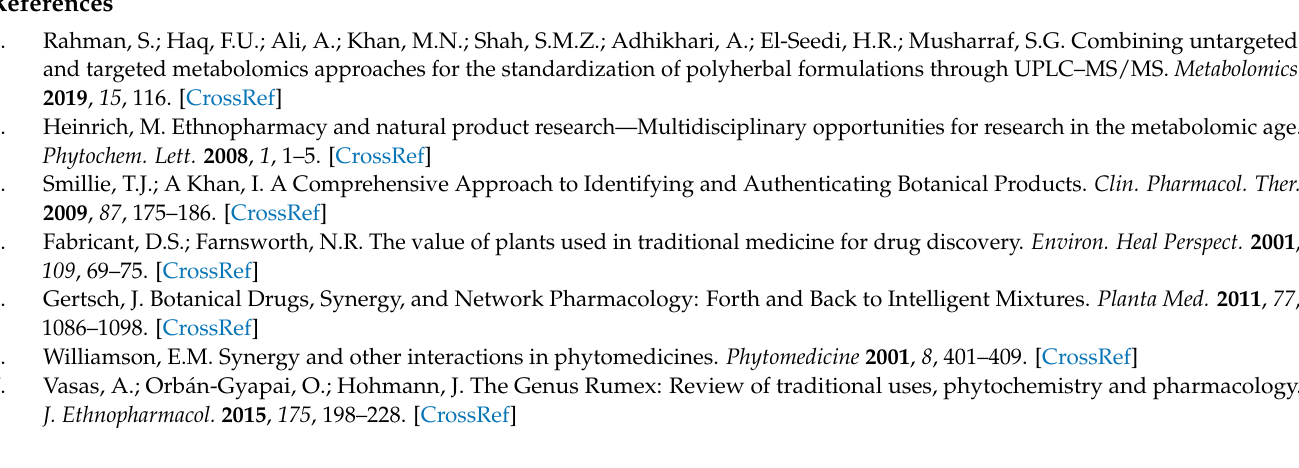
values Table S3: Correlation matrix (Spearman) showing correlation coefficients computed for the main significant metabolite classes, antioxidant capacity, antifungal activity, and antibacterial